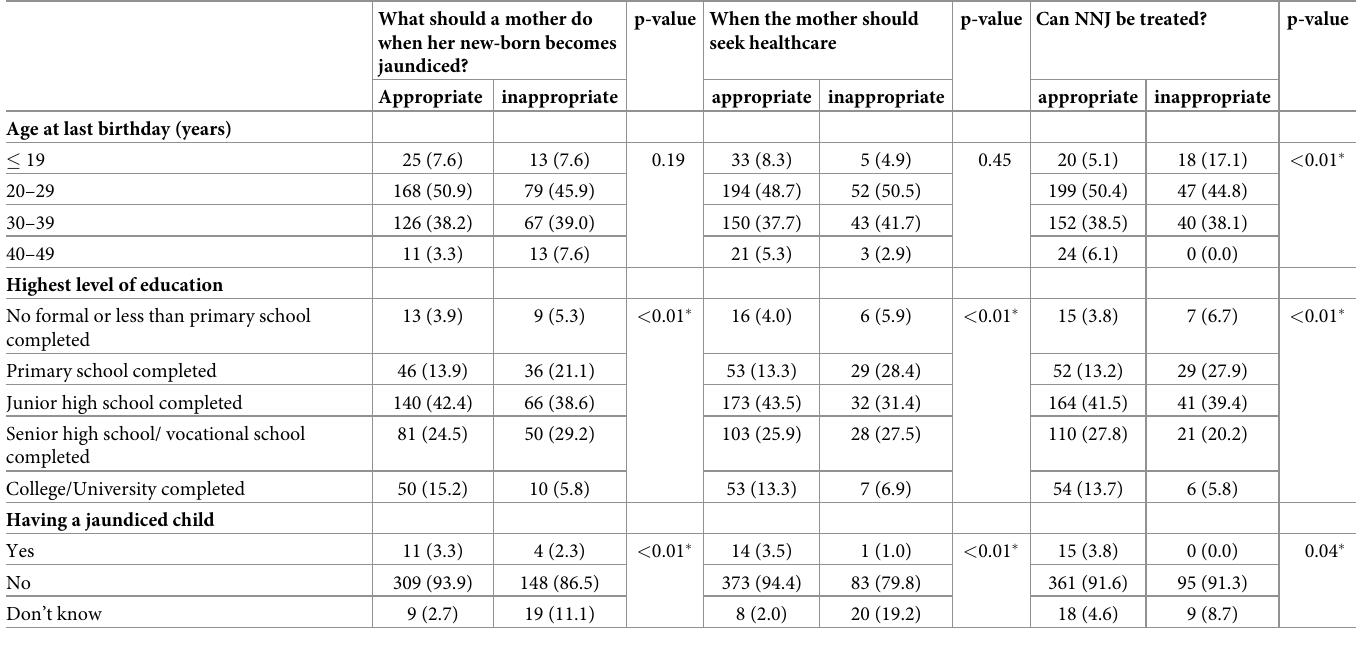
Table 6. Association between selected characteristics of mothers and attitude/perceptions towards neonatal jaundice.